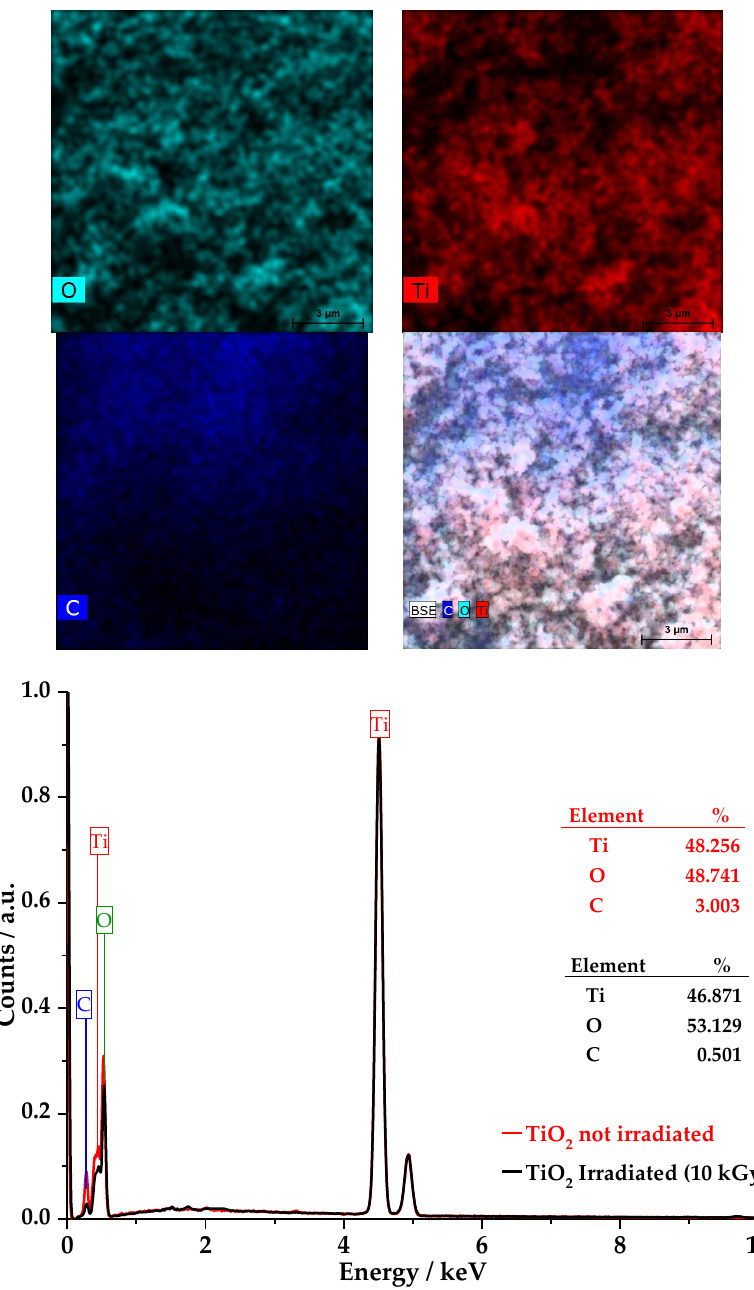
Figure 6. Energy-Dispersive X-ray Spectroscopy (EDS) mapping of composition of sample of TiO 2 without irradiation, and EDS spectrum of irradiated and unirradiated TiO 2 .